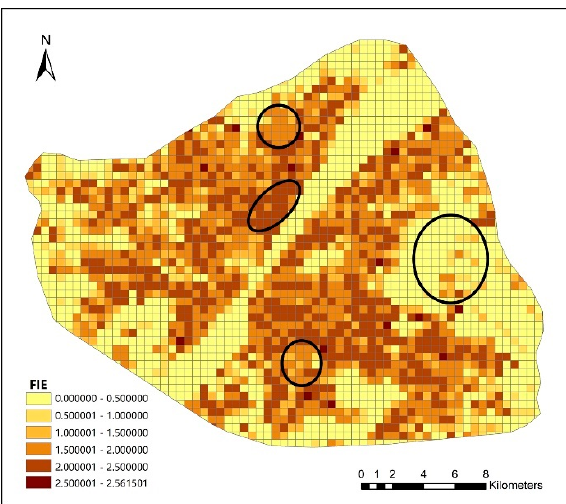
Figure 11. Functional information entropy (FIE) based on POI data.